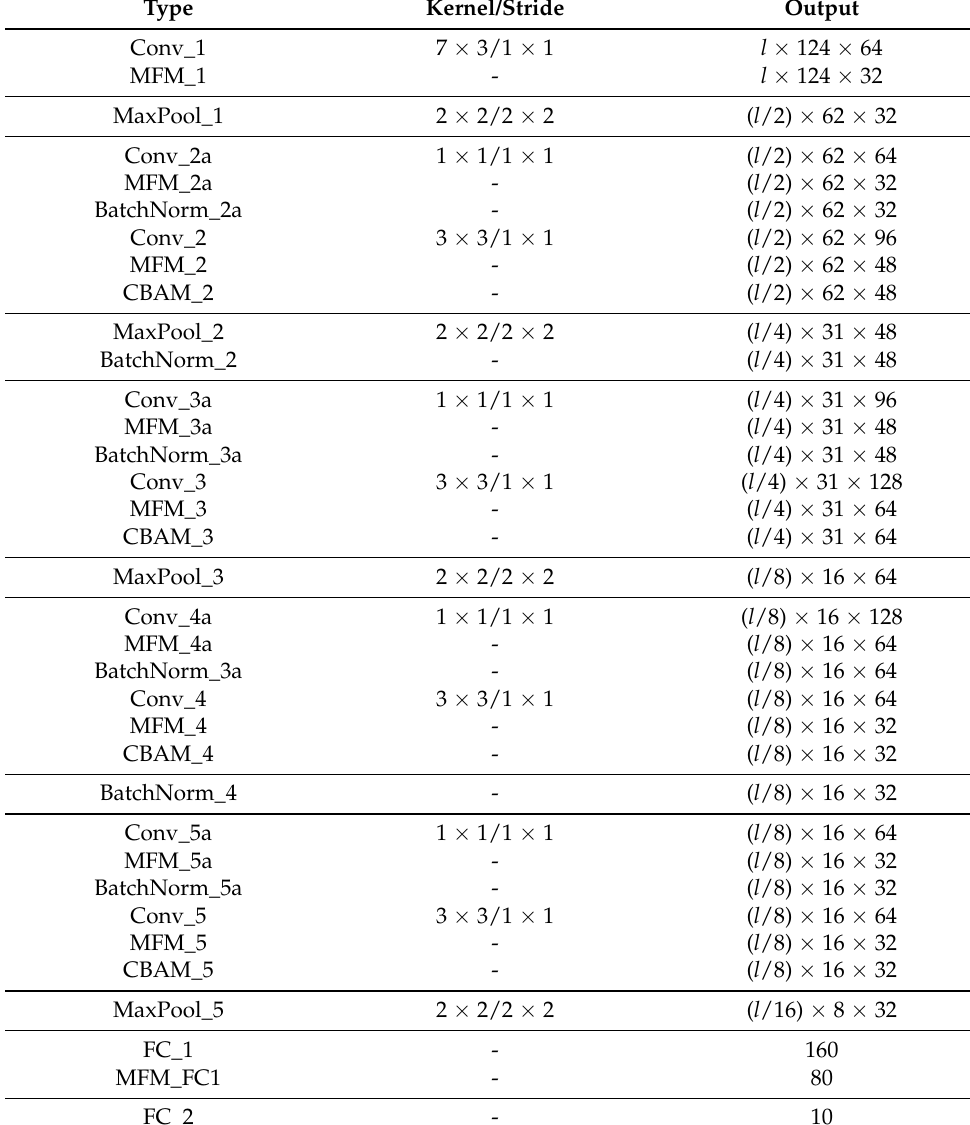
Table 1. The LCNN architecture. The numbers in the output shape column refer to the frame (time), frequency, and number of channels. MFM, MaxPool and FC indicate the max feature map, max pooling layer, and fully-connected layer,